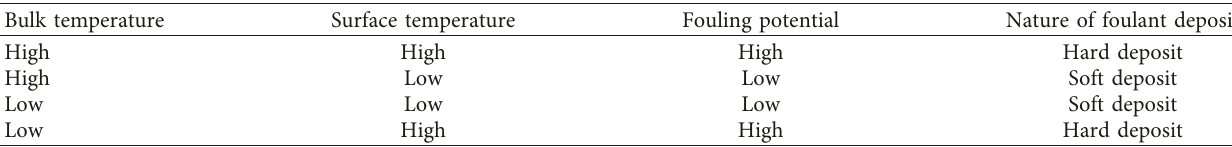
Table 6: Fouling potential of refinery streams based on the combination of bulk and surface temperature. Bulk